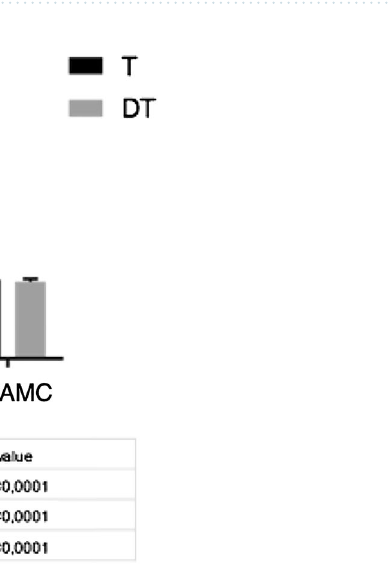
Figure 7. ( A ) Eppendorf tubes containing saline solution; ( B ) Bacterial solution transferred to a Petri dish with BHIA; ( C ) Harvesting of bacterial subculture in a Petri dish; ( D ) Subculture dishes in a bacterial growth chamber.